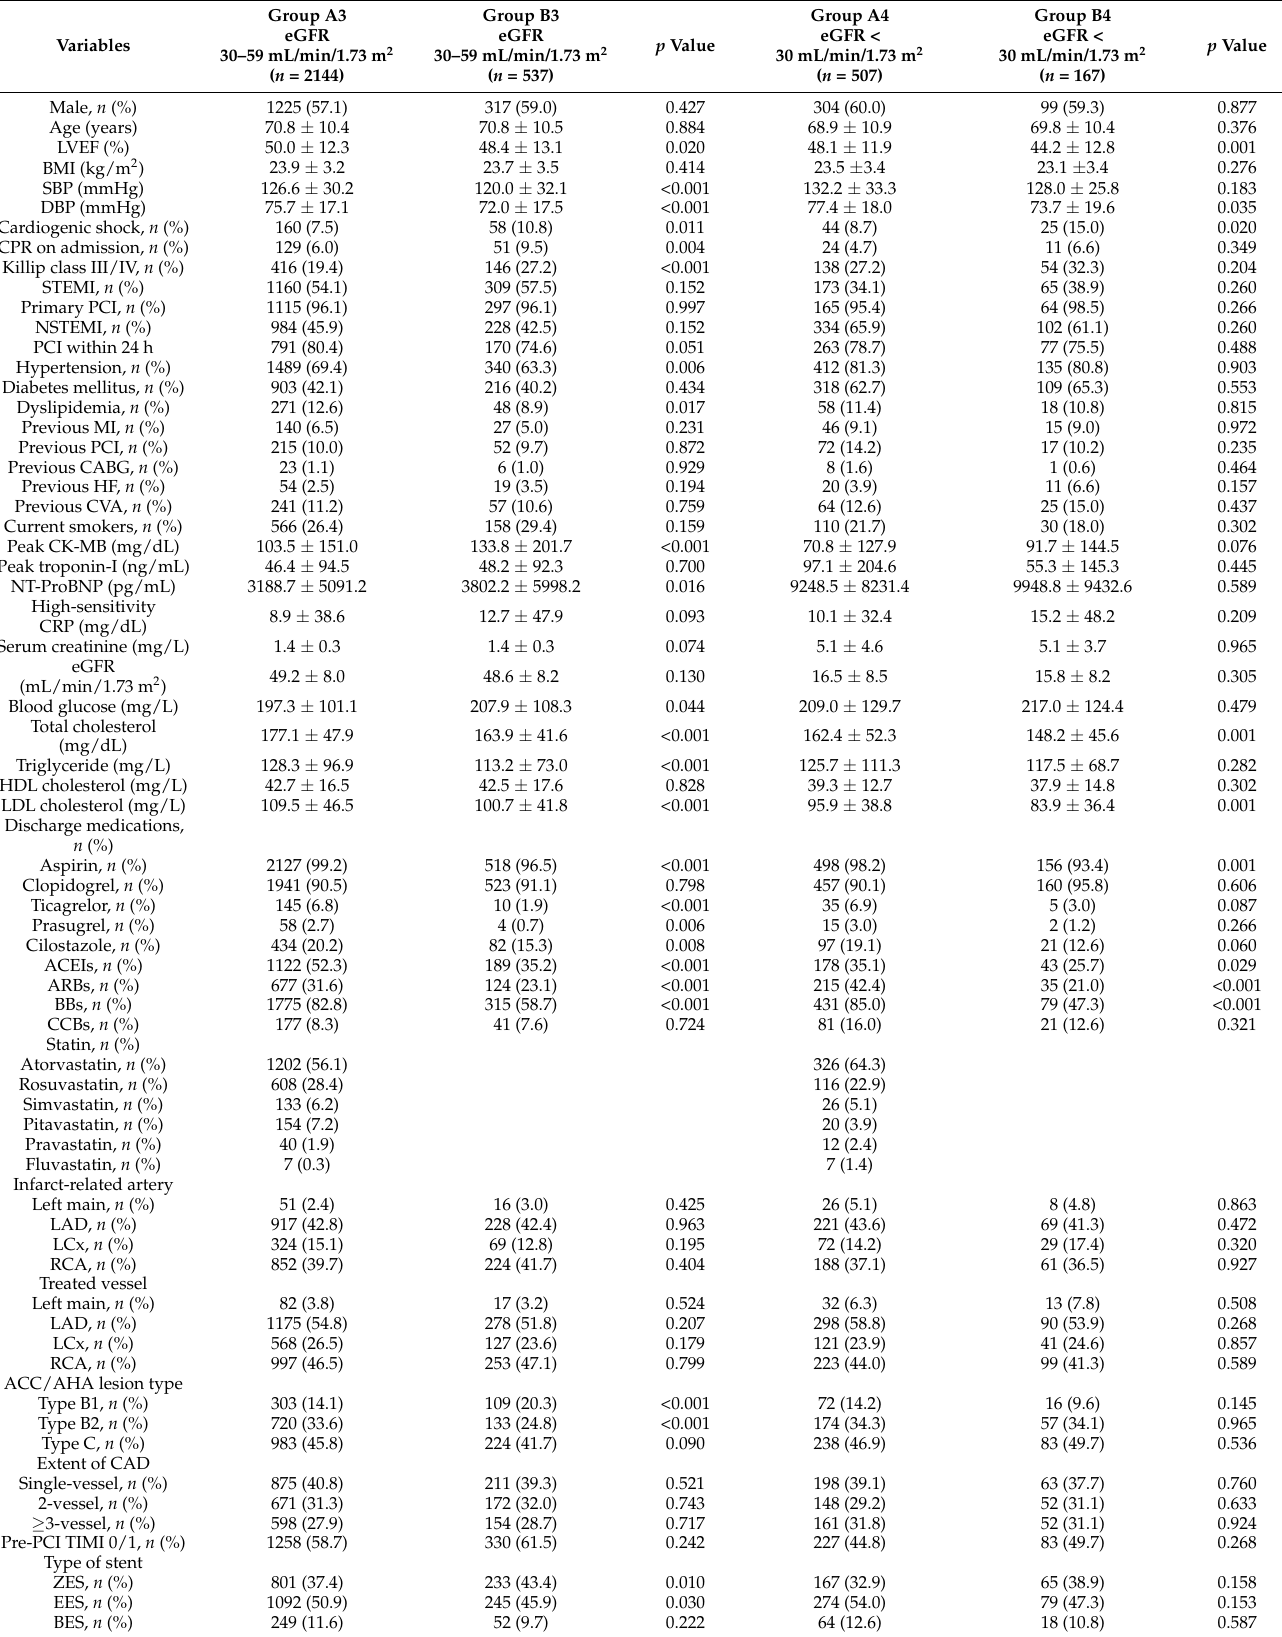
Table 4. Baseline characteristics between statin users and nonusers